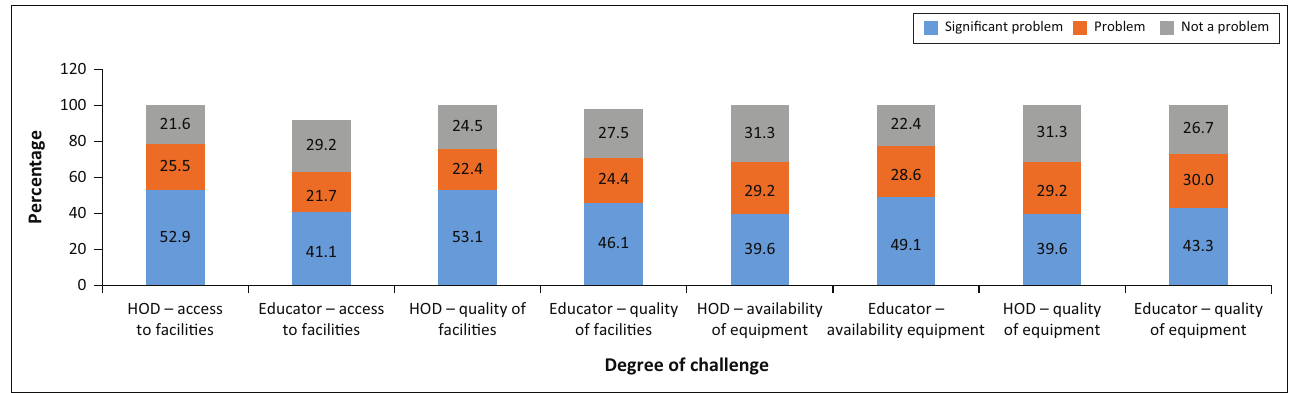
FIGURE 5: Perceived challenges in implementing physical